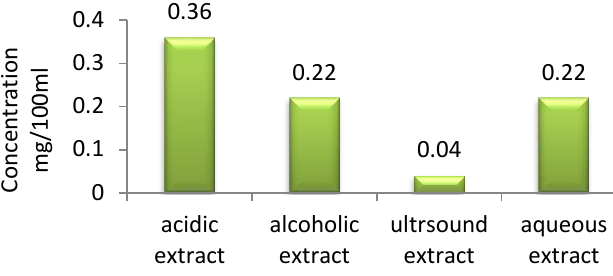
Figure 6. Total polyphenol content.